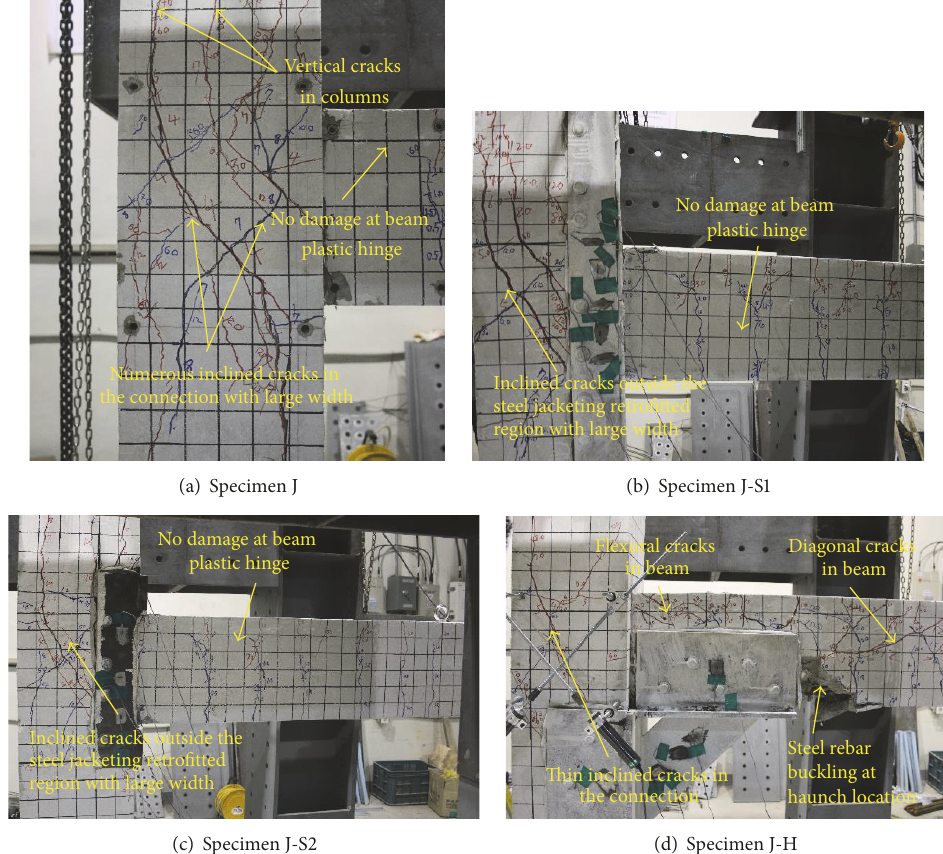
Figure 9: Failure modes of test specimens at the end of